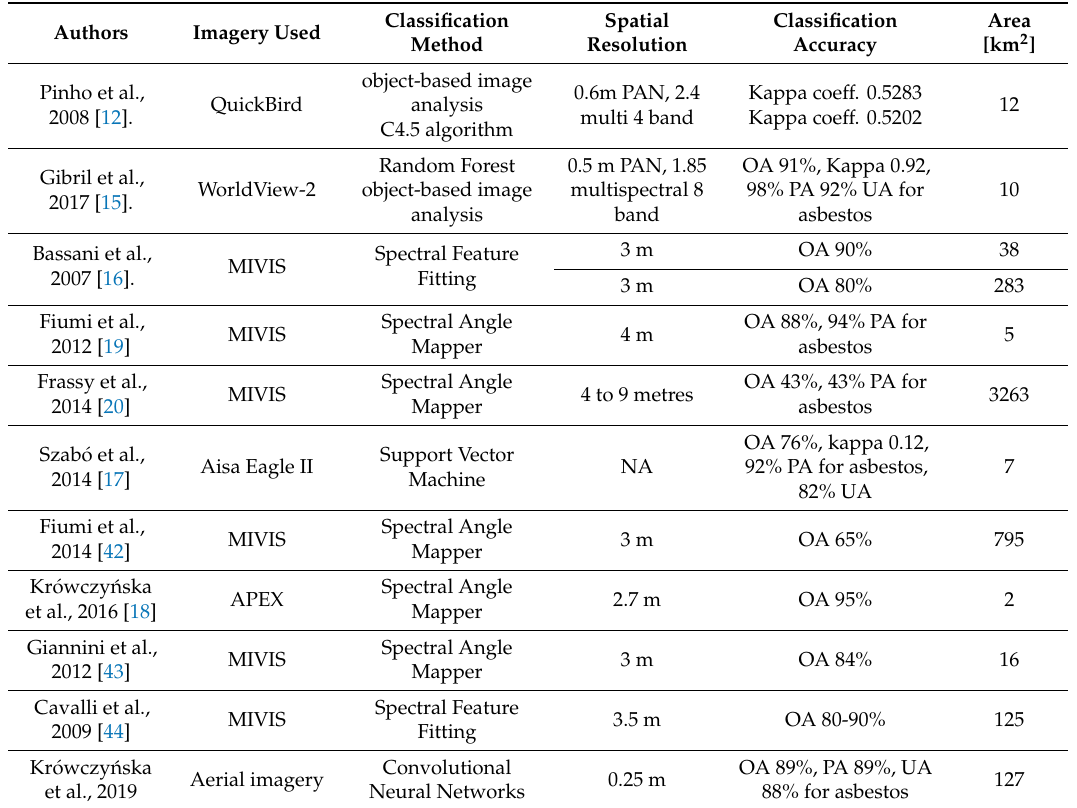
Table 3. Summary of the classification results of the classification of asbestos cement roofing with the use of remote sensing